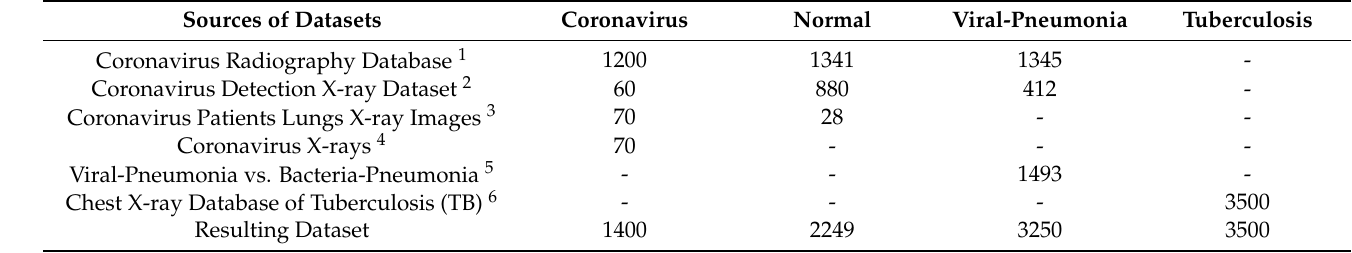
Table 2. Sources of data were utilized to create a consolidated dataset with four classes [29].